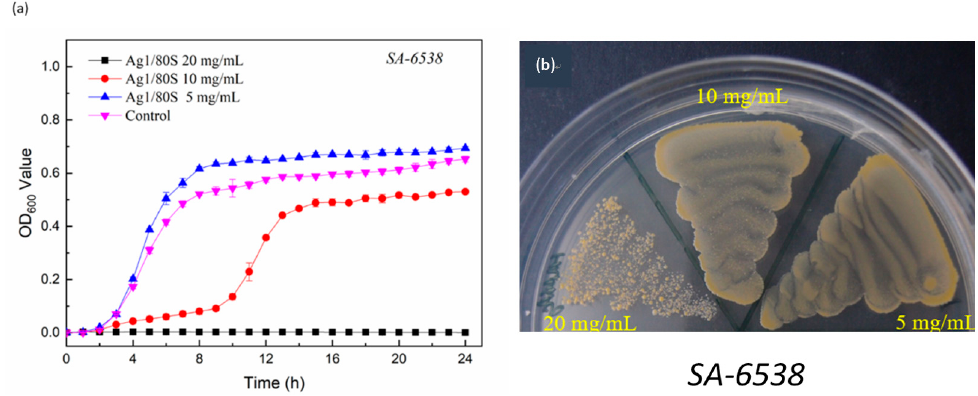
Figure 8. Microbiological assay of Ag1/80S against S. aureus (ATCC 6538); ( a ) kinetics curves of microbial growth; and ( b ) colony-forming capacity assay.